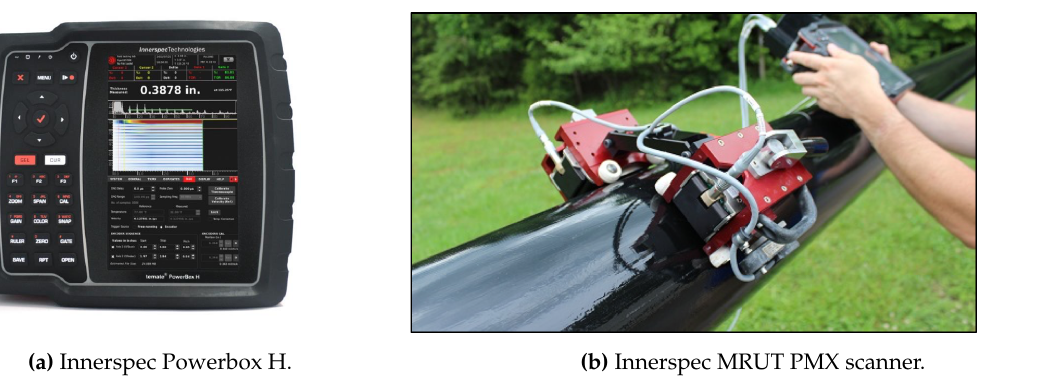
Figure 5. Measuring equipment used in the